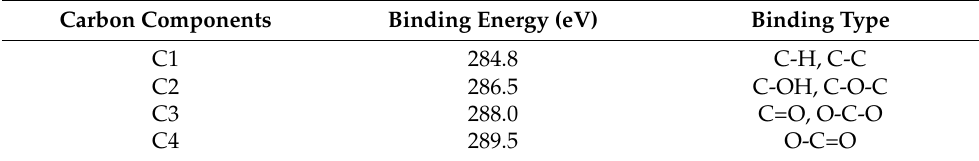
Table 3. Binding energy and binding type of the four carbon components in wood.